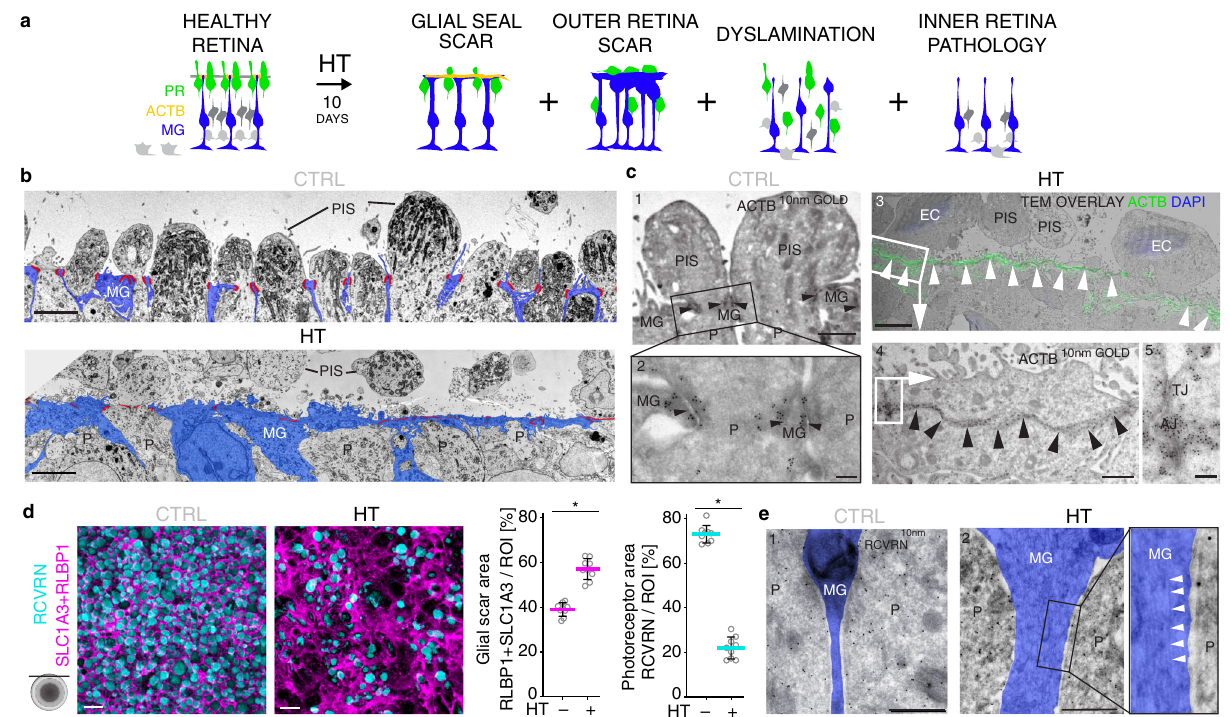
Fig. 5|HBEGF-TNF-treatedHROsshowglialscarformation.a Schematic:retinal dyslamination and glial pathologic changes investigated(10-days HBEGF-TNF (HT) treatment). b Transmissionelectronmicroscopyofepoxy-embeddedHROsections with HT treatment/without (CTRL): images of the most apical HRO regions show photoreceptors (P) with inner segments (PIS) that contain mitochondria and are interconnected with Müller glia (MG). Pseudocolors: cell junctions (red lines), MG (blue). N =1 independent experiment ( N ) with n =3 HROs. c Correlative-light elec- tron microscopy: in control HROs, ACTB immunostaining, visualized by gold par- ticles(blackdots,10nmgold),wasrestrictedtocelljunctions( c1,2 :arrowheads)of the OLM and apical microvilli of MG. Conversely, prominent electron-dense, fi la- mentous structures spanning between cell junctions (arrowheads) were observed inHT-HRO:thesewerecon fi rmedtobeactin fi laments(ACTB+, c3 – 5 ).Extrudedcell nuclei(EC)stainedwithDAPIarefrequentlyobservedinHT-HROs,butnotcontrols. N =1 independent experiment ( N ) with n =3 HROs. d En-face images of HRO